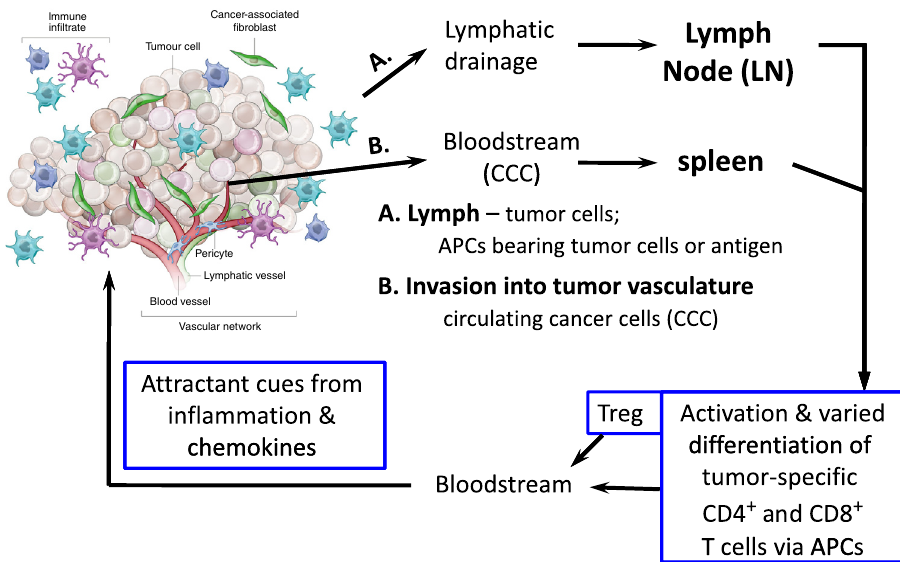
Figure 4. T cells and the tumor. Shown is a simplified overview of the multiple and diverse sites at which each type of T cell may encounter signals and tumor-derived antigens during growth and metastasis for carcinomas, together with a diagram underscoring likely variations of malignant cells within the tumor mass itself. In addition to action within the tumor itself, which may not be a site of initial tumor antigen presentation to and activation of T cells, either live or dead tumor cells, or antigens derived from them, traffic and flow to secondary lymphoid organs (spleen; lymph node), in either particulate or cell-associated (e.g. within a dendritic or movable phagocytic cell) form. APC, antigen-presenting cell; Treg, regulatory